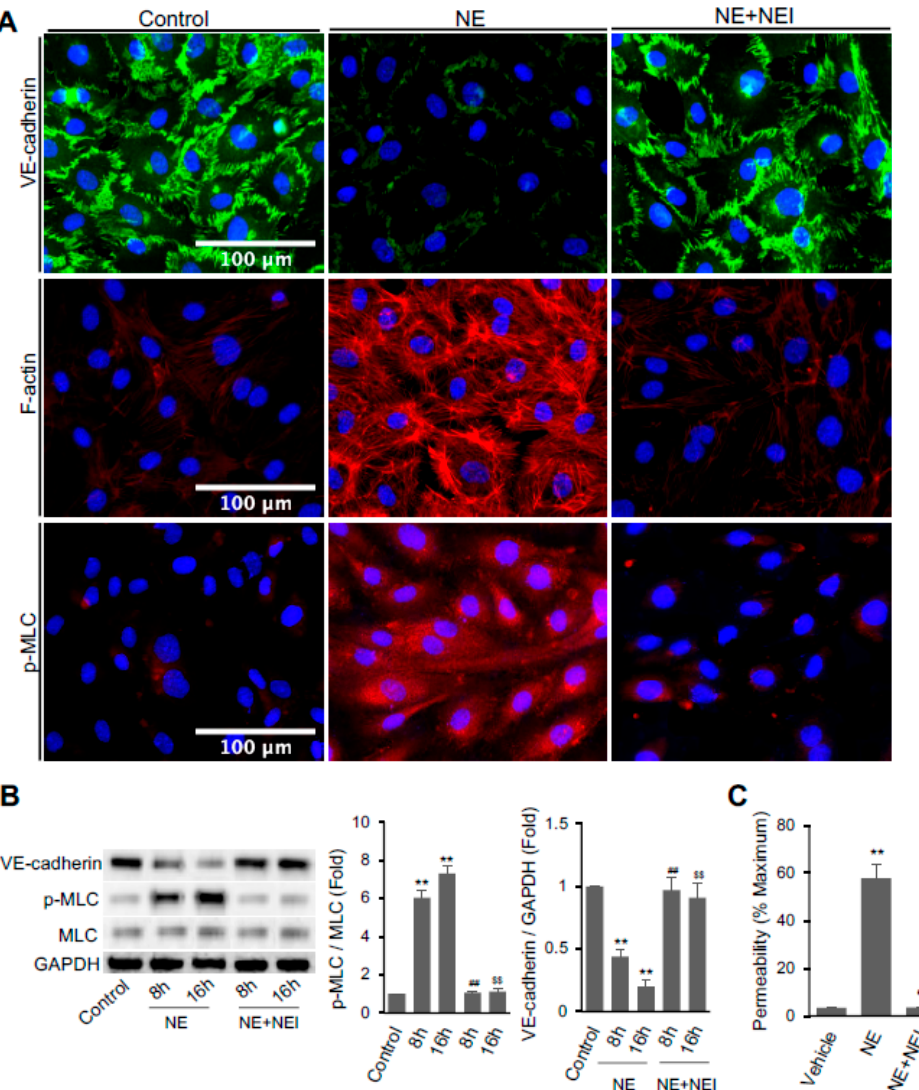
Figure 1. Neutrophil elastase (NE) decreased VE-cadherin protein and increased F-actin formation, MLC phosphorylation, and permeability in hECs. ( A ) Confluent hECs were treated with the vehicle or 20 nM NE in the presence or absence of NE inhibitor GW311616A (NEI, 1 µ M) for 16 h. Cells were fixed and fluorescence labeled with antibodies against VE-cadherin (Alexa-Fluor 488, green, top panel) and p-MLC (pSer19, Alexa-Fluor 568, red, lower panel) or phalloidin (ifluor 594, red, middle panel) to analyze the distribution of VE-cadherin, p-MLC, and F-actin. Images were taken at 20 × magnification (scale bar, 100 µ m). Representative images were chosen from three independent experiments. ( B ) Western blot analysis of VE-cadherin, p-MLC, total MLC, and GAPDH in hECs treated with or without NE for 8 or 16 h in the presence or absence of NEI (1 µ M). ( C ) hEC permeability assay Lucifer Yellow dye. Graph shows endothelial cell permeability after 16 h of NE treatment. ( B , C ) All data are presented as mean ± SD of three independent experiments. ** p < 0.01 vs. vehicle control group, ## p < 0.01 vs. NE-8h group, and $$ p < 0.01 vs. NE-16h group. NE: neutrophil elastase (20 nM), NEI: neutrophil elastase inhibitor. Control vehicle used for the experiment was PBS containing 0.5 mM sodium acetate that was used for dissolving purified NE. See also Figure S1.